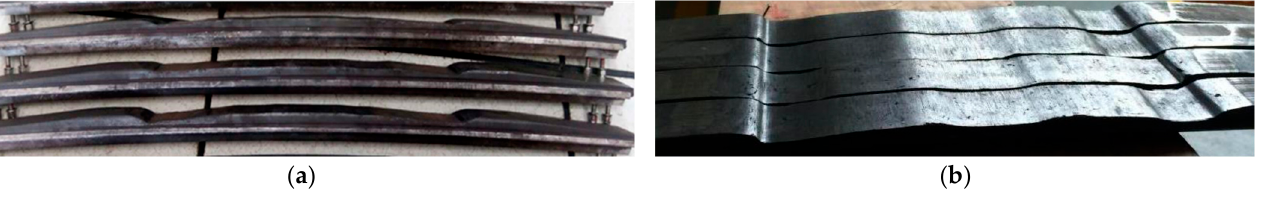
Figure 3. Pantograph strip average daily wear rate before and during irregular wear.